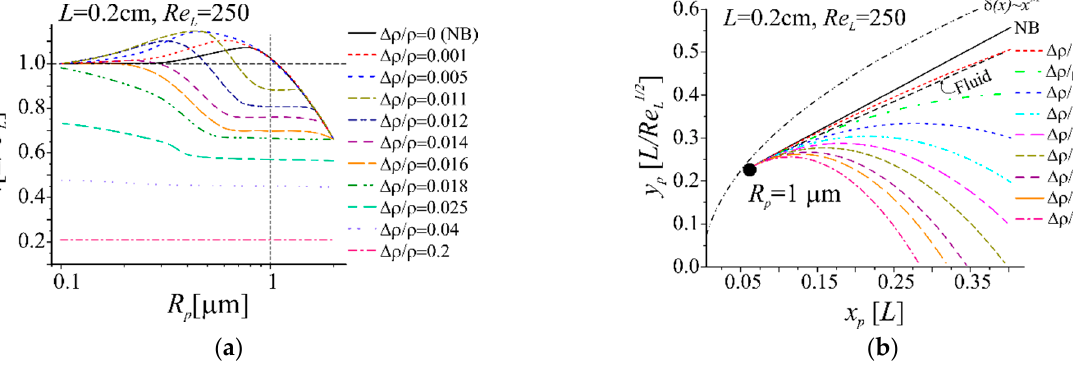
Figure 10. ( a ) Typical run of the curves τ ( R p ) for small and light particles. ( b ) Typical trajectories for a particle with R p = 1 µ m for a range of relative densities. The black dashed line concerns the case of neutrally buoyant fine particles.